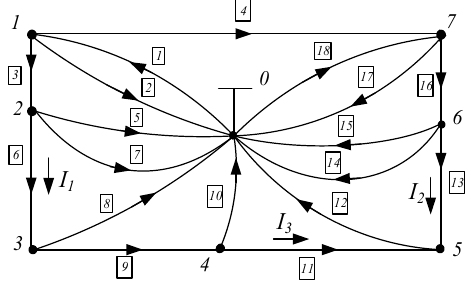
(27) The obtained equations (Equations (1)–(27)) allow the main electrical quantities (currents, voltages, and powers) under voltage magnitude, phase angle, and combined TVR control modes to be determined. The calculation was carried out using the Mathcad program. As a result of the calculations, the dependences of the power, voltage, and current of the DN on the additional voltage were obtained. The calculations show that accounting for the transformers’ magnetization branches and the reactive power generated by 110 kV power transmission lines has a small effect on the currents and power flows transmission in the lines. Neglecting these parameters introduces an inaccuracy in the calculations of less than 0.5%. Thus, in further calculations, in order to reduce the number of equations, simplify the model, and reduce the simulation time, these parameters can be ignored. 4. Simulation of the DN Operating Modes in Matlab Simulink A simulation model was developed for the MV DN (Figure 10) in order to verify the analytical calculations obtained by the matrix-oriented method [21]. The model was developed in the MATLAB Simulink according to the equivalent circuit (Figure 7).